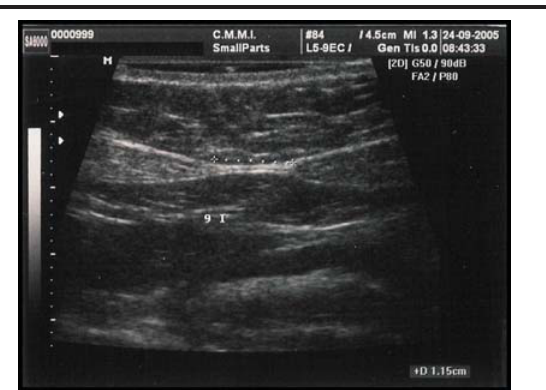
FIGURE 2 - Ultrasonographic image at supra umbilical level, showing a good visualization of rectus sheath which is highly echogenic as compared to the mainly hipoechoic muscle.